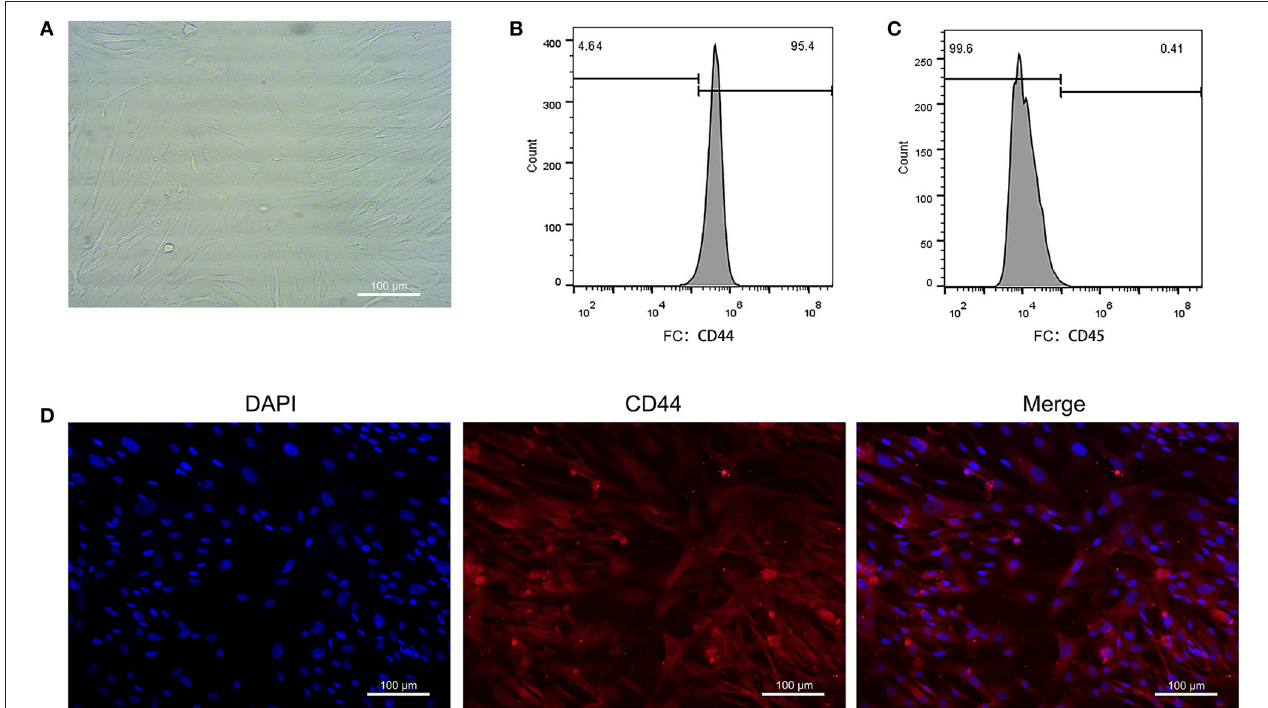
FIGURE 2 | Primary culture of EASCs and its identification. (A) Morphology of EASCs under microscope. (B) Flow cytometry of CD44 positive cells in EASCs. (C) Flow cytometry of CD45 positive cells in EASCs. (D) Immunofluorescence staining of CD44 in EASCs climbing slices.